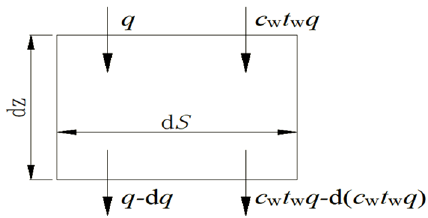
Figure 4. Finite control volume for water flow.